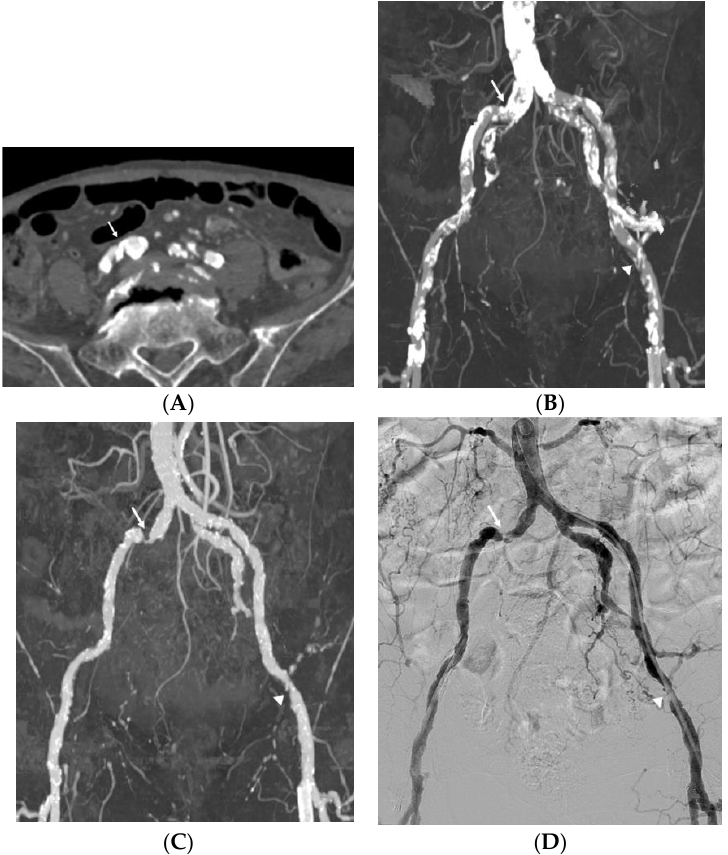
Figure 2. Imaging study of an 82-year-old man with claudication and calcified plaques in the right common femoral artery. Reliable stenosis evaluation was limited due to severe vascular wall calcification (arrow) in the standard reconstruction axial image ( A ) and maximum intensity projection (MIP) image ( B ). Dual-energy computed tomography (CT) automatic plaque removal MIP image ( C ) shows hemodynamically significant stenosis (arrow) confirmed by the digital subtraction angiography (DSA), which is the gold standard ( D ). Another hemodynamically significant stenosis (arrowhead) of the left external iliac artery on the automatic plaque removal MIP image also showed good correlation with